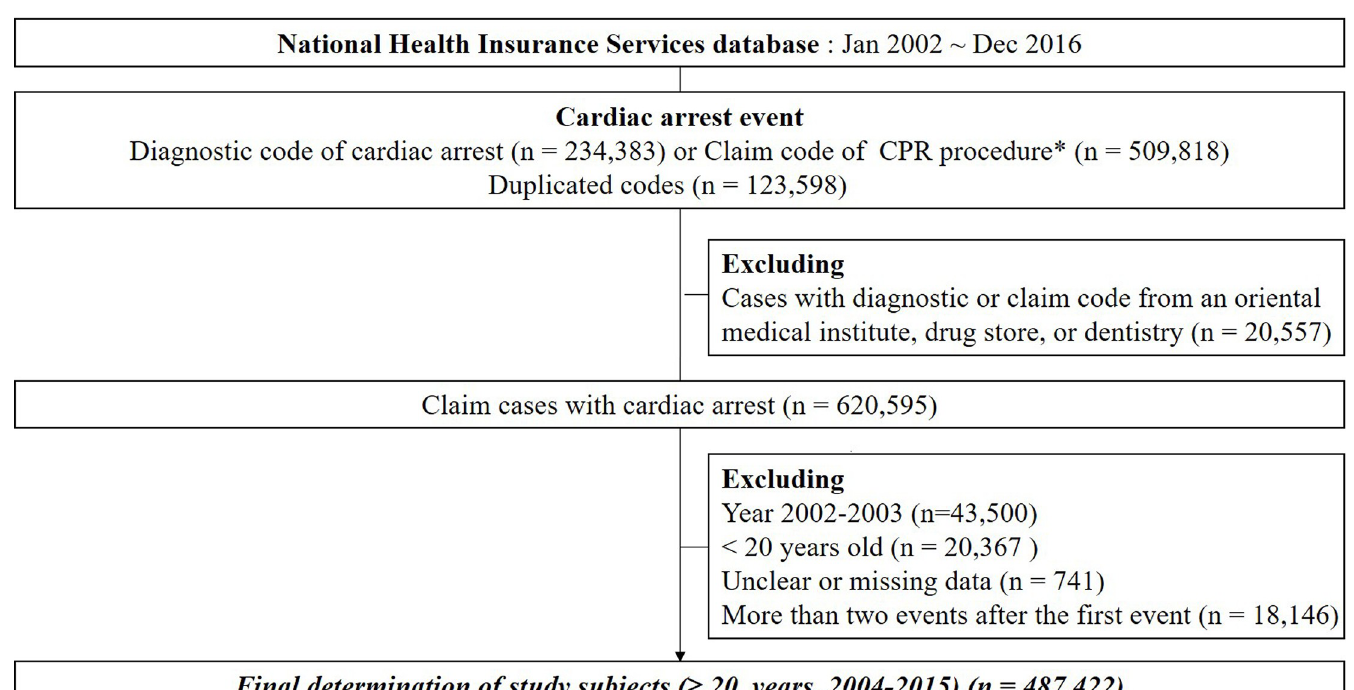
Fig 1. Flowchart of the selection of study